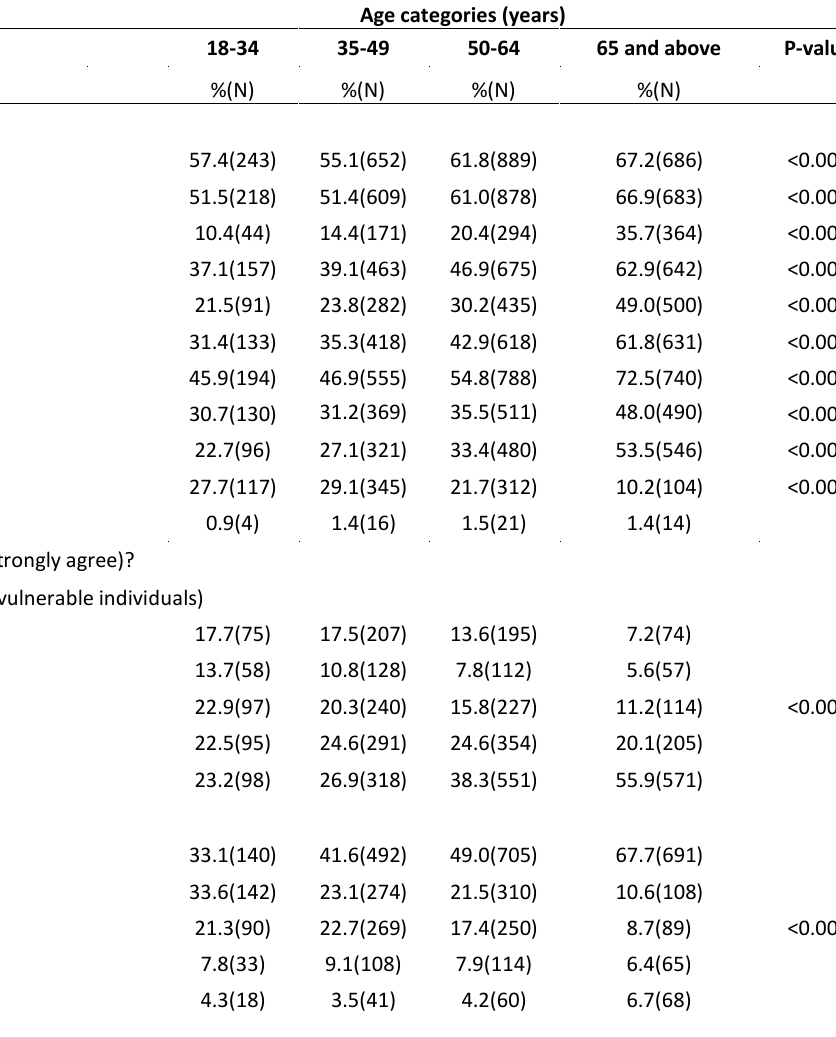
Table S3. Stratified results by age categories, sex, education level, household income, employment status, occupational position, past SARS-CoV-2 infection, vaccination willingness, and vaccination